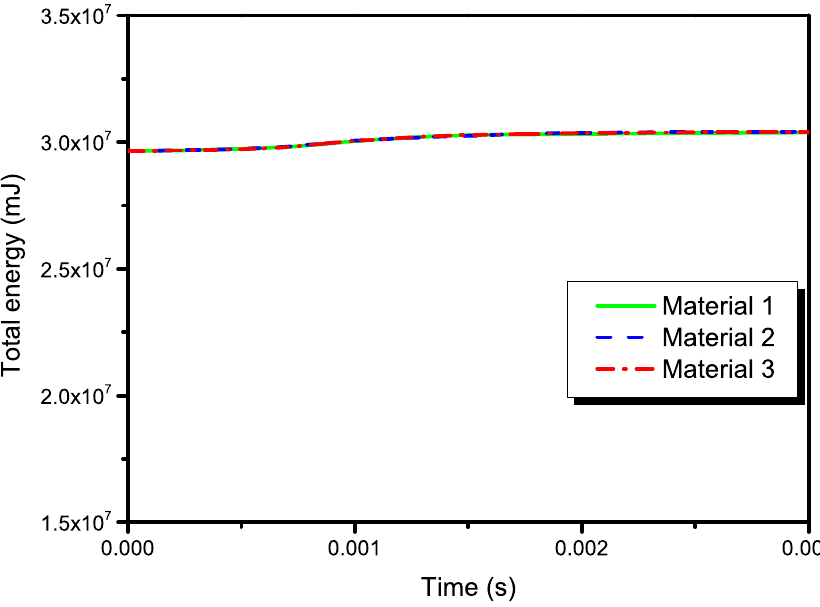
Figure 18. Time histories of the total energy in the three models.